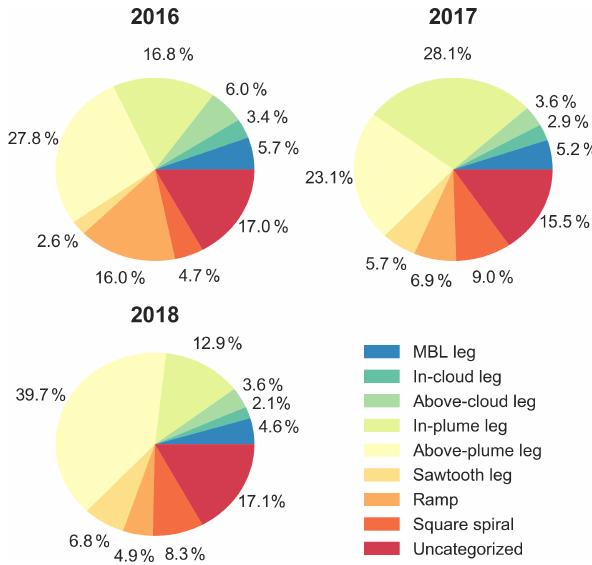
Figure A1. Distribution of flight time between flight maneuvers for each ORACLES deployment